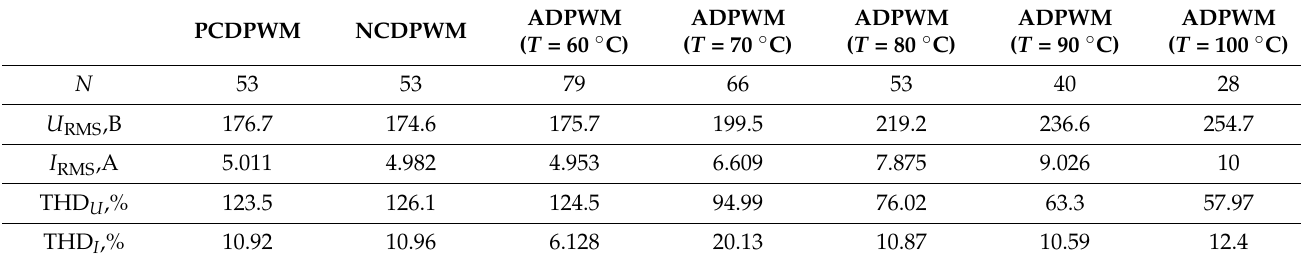
Table 2. Simulation results at MI = 0.5.